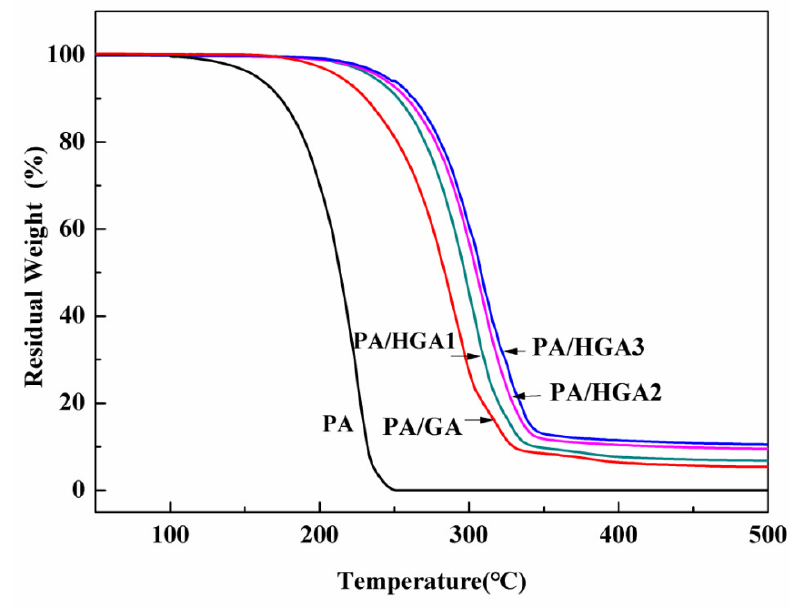
Figure 9. TGA curves of PA and PA/HGA.